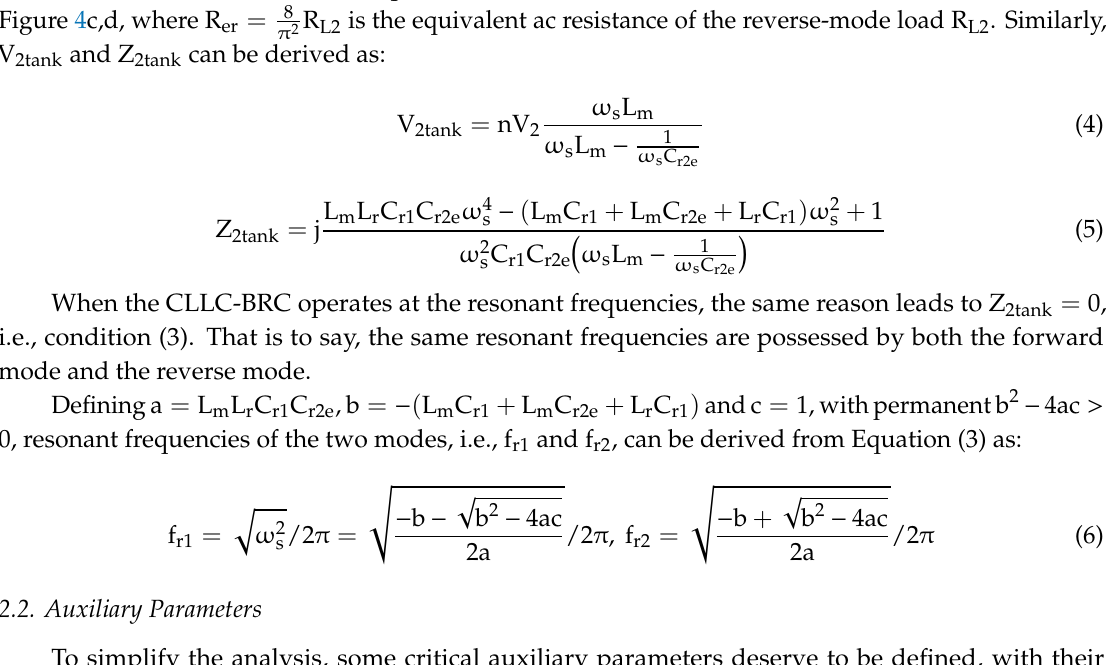
Table 1. Auxiliary parameters’ definitions.